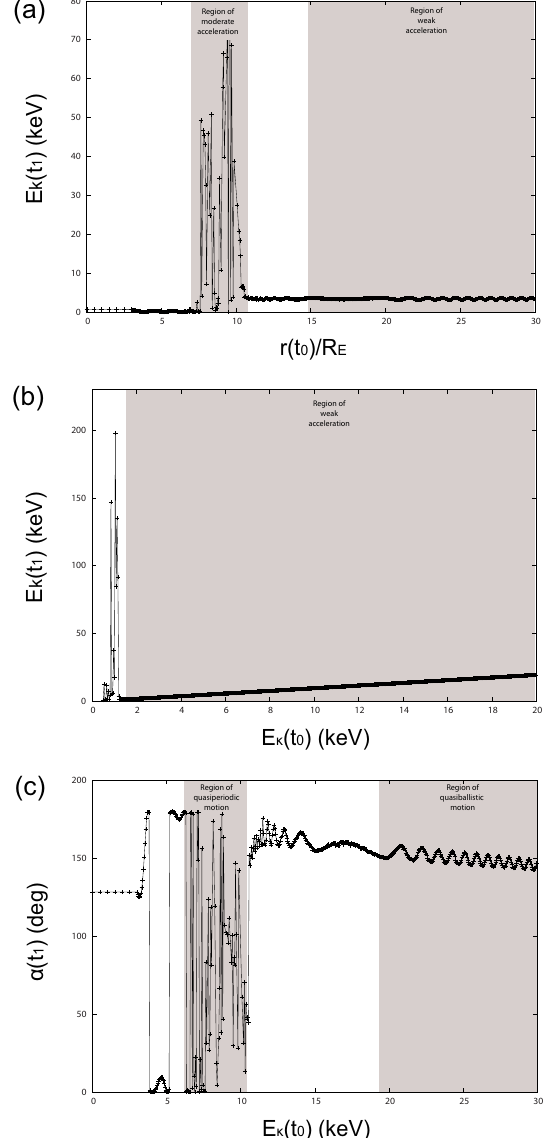
Figure 10. Final kinetic energy of N ens = 1000 H + ions as a func- tion of the initial (a) radial coordinate, (b) kinetic energy, and (c) fi- nal pitch angle as a function of initial kinetic energy, for varying initial conditions and all the remaining quantities same as in Fig. 9.